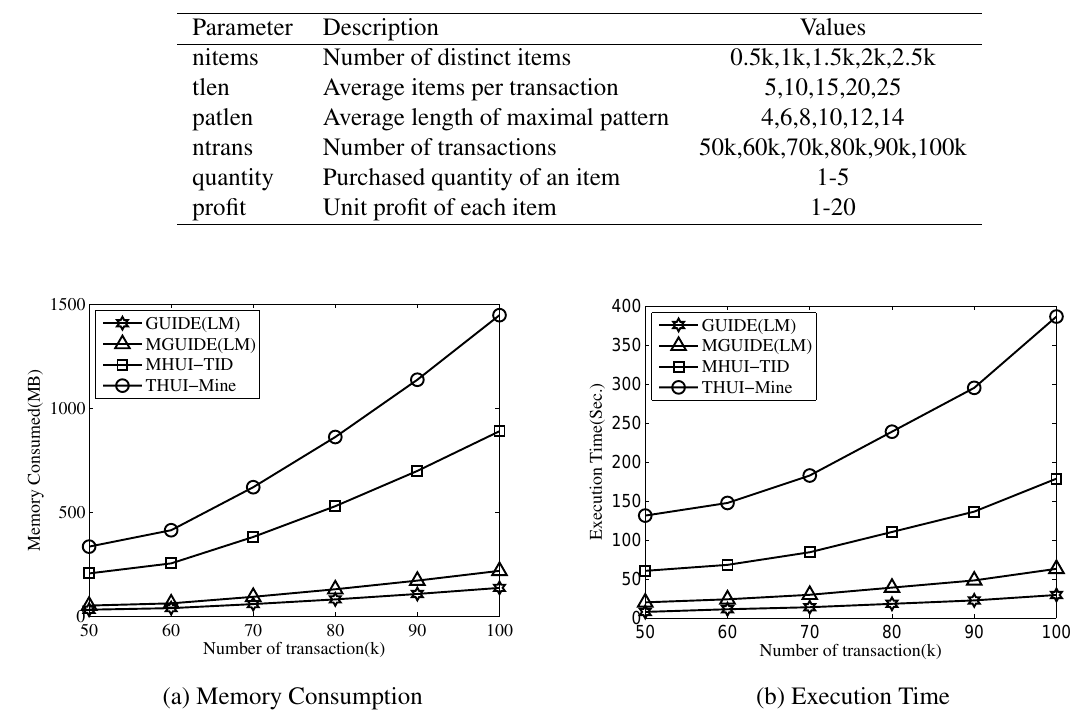
Fig. 5: Performance with varying number of transactions